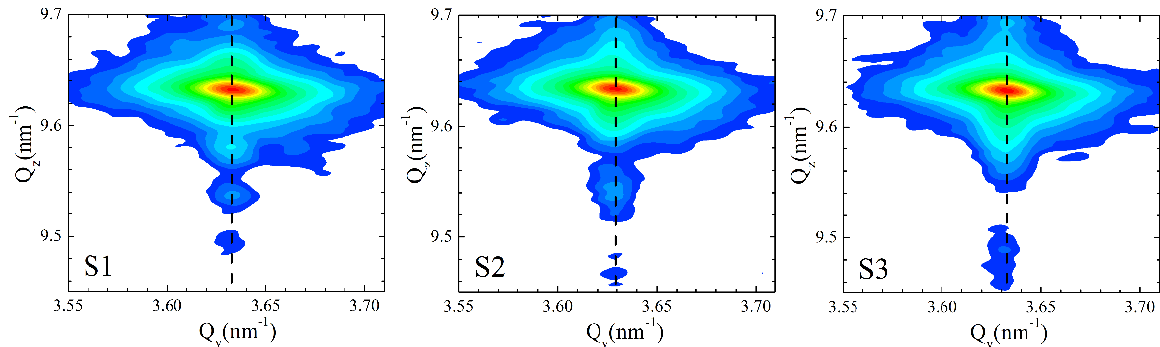
Figure 4. Reciprocal space maps of X-ray diffraction around the asymmetric (105) orientation for all samples. Qy and Qz are the reciprocal space vectors in nm − 1 . The dashed line indicates the vertical position of the reflection of the GaN peak.